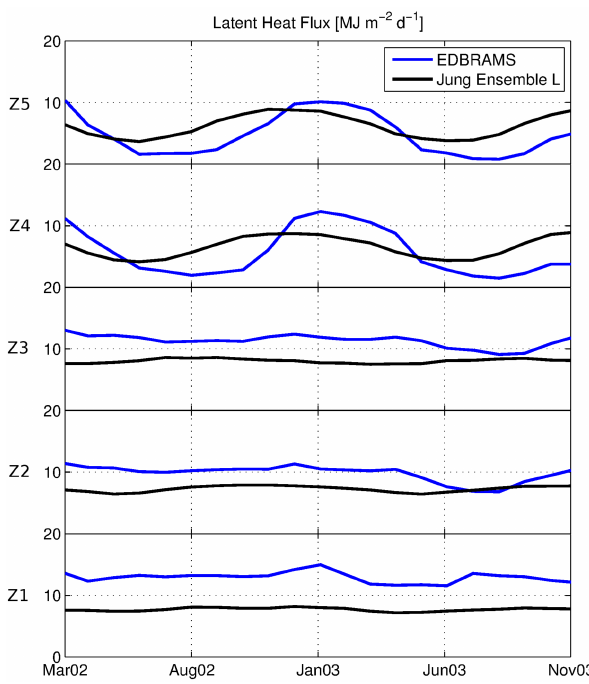
Figure E1. Mean monthly surface-to-atmosphere latent heat flux from ED2-BRAMS and the synthesis product from Jung et al. (2011, 2009). Spatial means are calculated over the zones shown in Fig. B2.